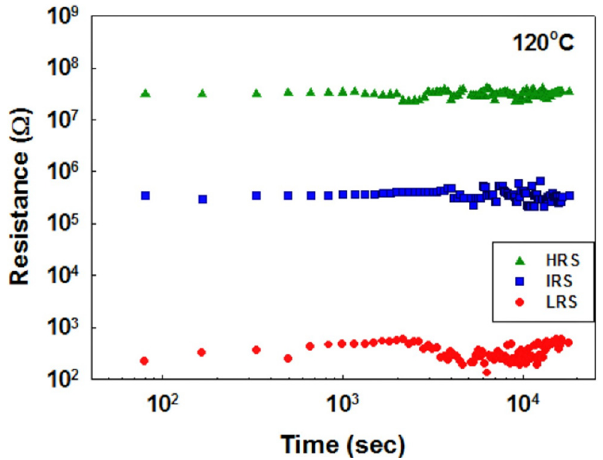
Figure 10. Retention property of the Au/Ni/SiO x N y /p + -Si memory device.